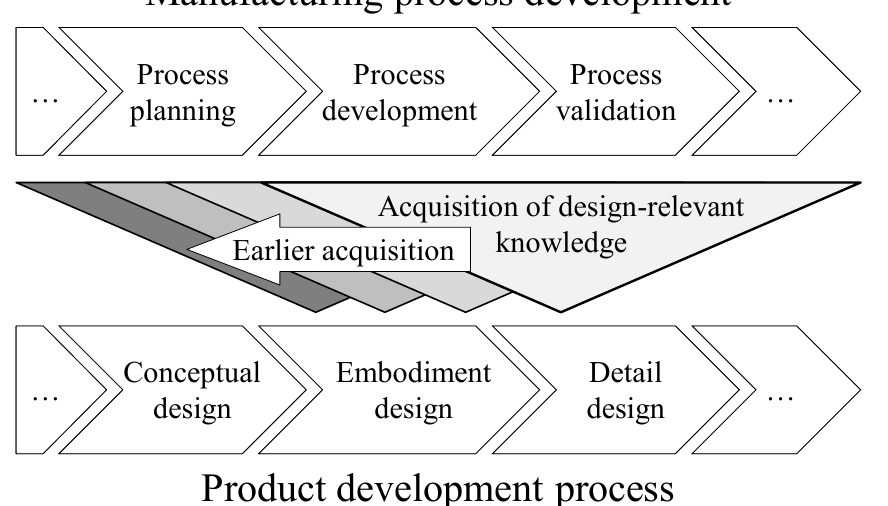
Figure 1. The acquisition of knowledge is necessary at an early point of process development; however, state-of-the-art is an acquisition of knowledge by the end of the process